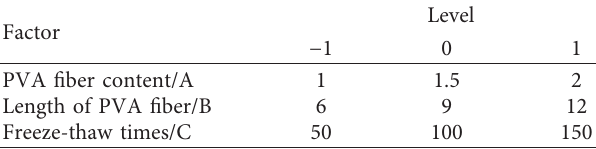
Table 3: Code and level of experimental factors. Factor